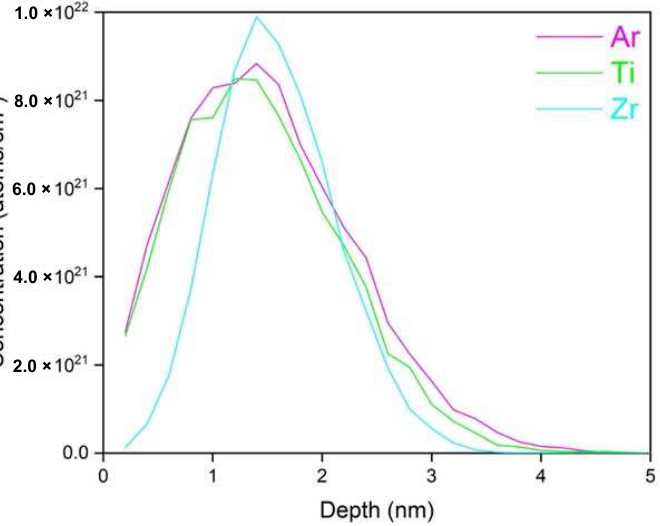
Figure 1. Concentration profiles of Ar, Ti and Zr species on 304L stainless steel calculated using SRIM 2013 versus implantation depth for 10 4 ions. Violet: Ar; green: Ti; cyan: Zr.